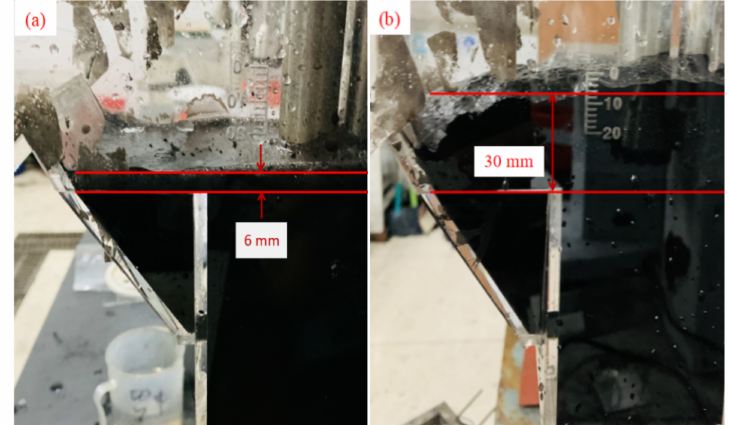
Figure 14. Top-view photos of froth produced in the presence of ( a ) kerosene and ( b ) emulsified kerosene. For conventional flotation (kerosene+ sec-Octyl alcohol), the collector and frother dosages were 500 g/t kerosene and 167 g/t sec-Octyl alcohol, respectively. For the mixture reagent (emulsified